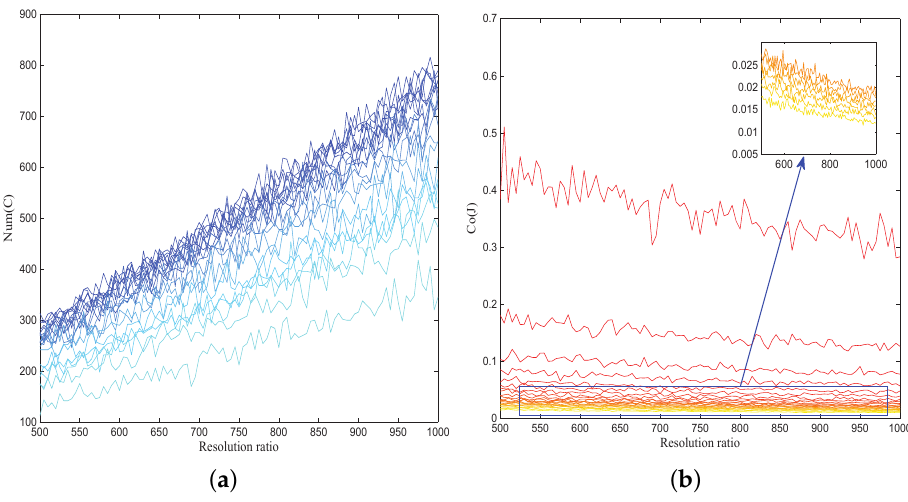
Figure 10. ( a ) The change curve of num ( C ) with the increase of M . ( b ) The change curve of Co ( J ) with the increase of M